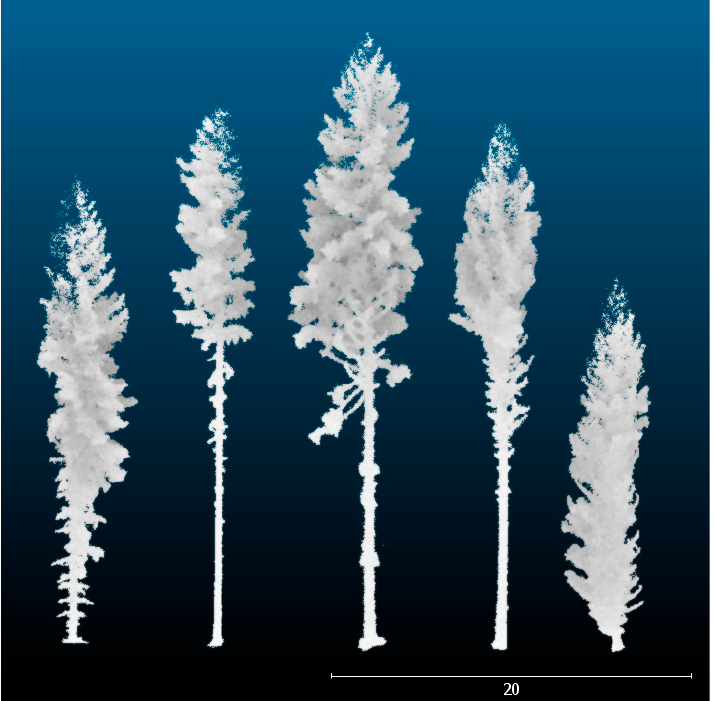
Figure 2. Point clouds of randomly selected individual Norway spruce trees as seen from the side (from left to right: P2–P6 with P = plot). The unit is equal to meter. (from left to right: P2–P6 with P = plot). The unit is equal to